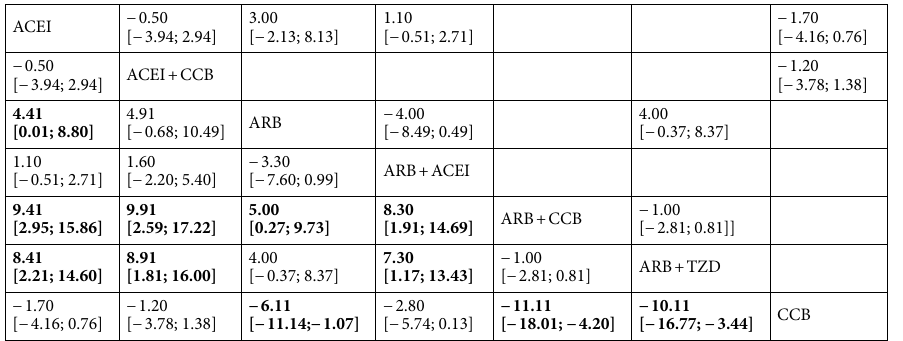
Table 4. Net league tables of changes in DBP. ACEI, angiotensin converting enzyme inhibitors; ARB, angiotensin receptor blockers; CCB, calcium channel blockers; DBP, diastolic blood pressure; SMD, standard mean difference; TZD, thiazide diuretics. Statistically significant values are expressed in bold.